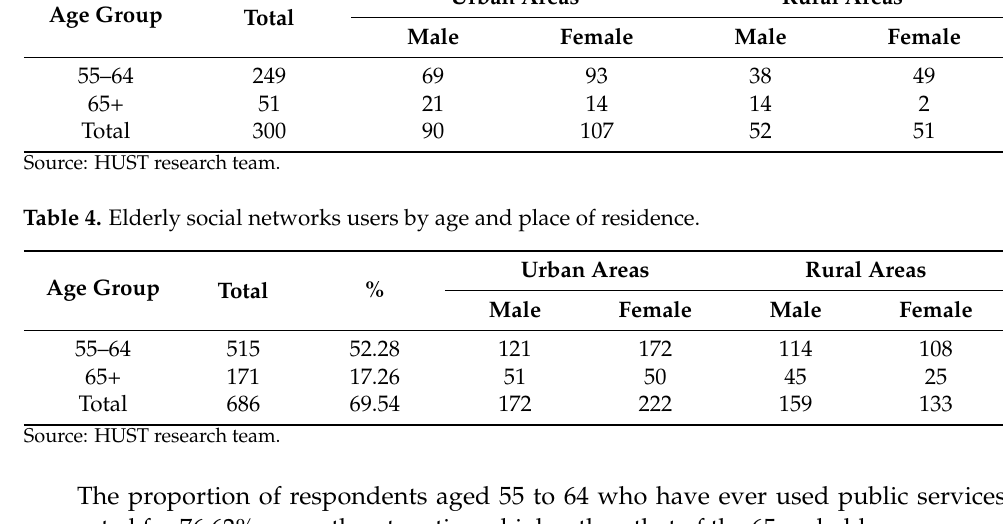
Table 3. The number of respondents participating in ecommerce by gender and place of residence. Urban Areas Age Group Total